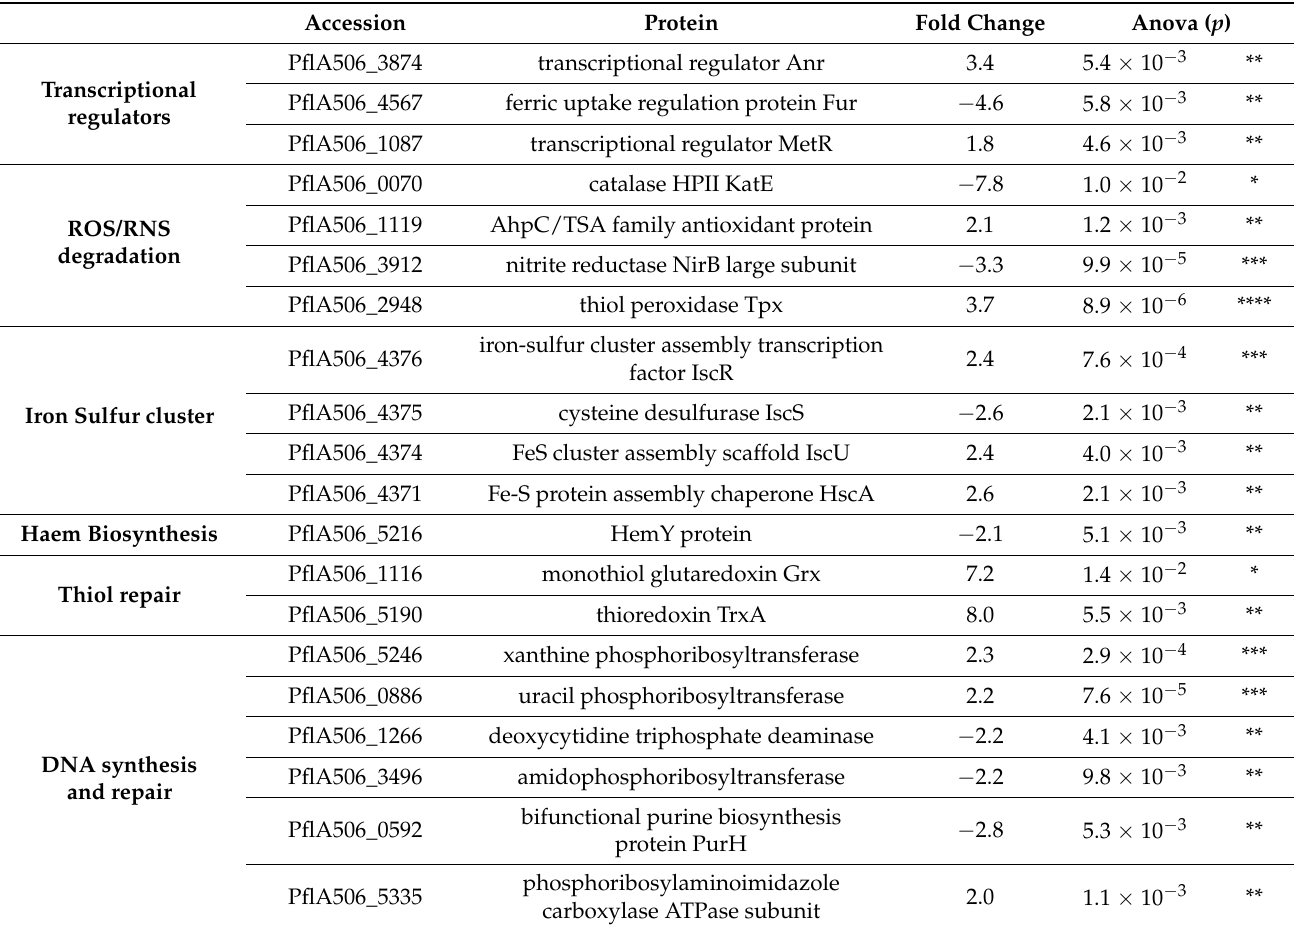
Table 3. Proteins involved in sensing, degrading and repairing RNS and ROS alterations